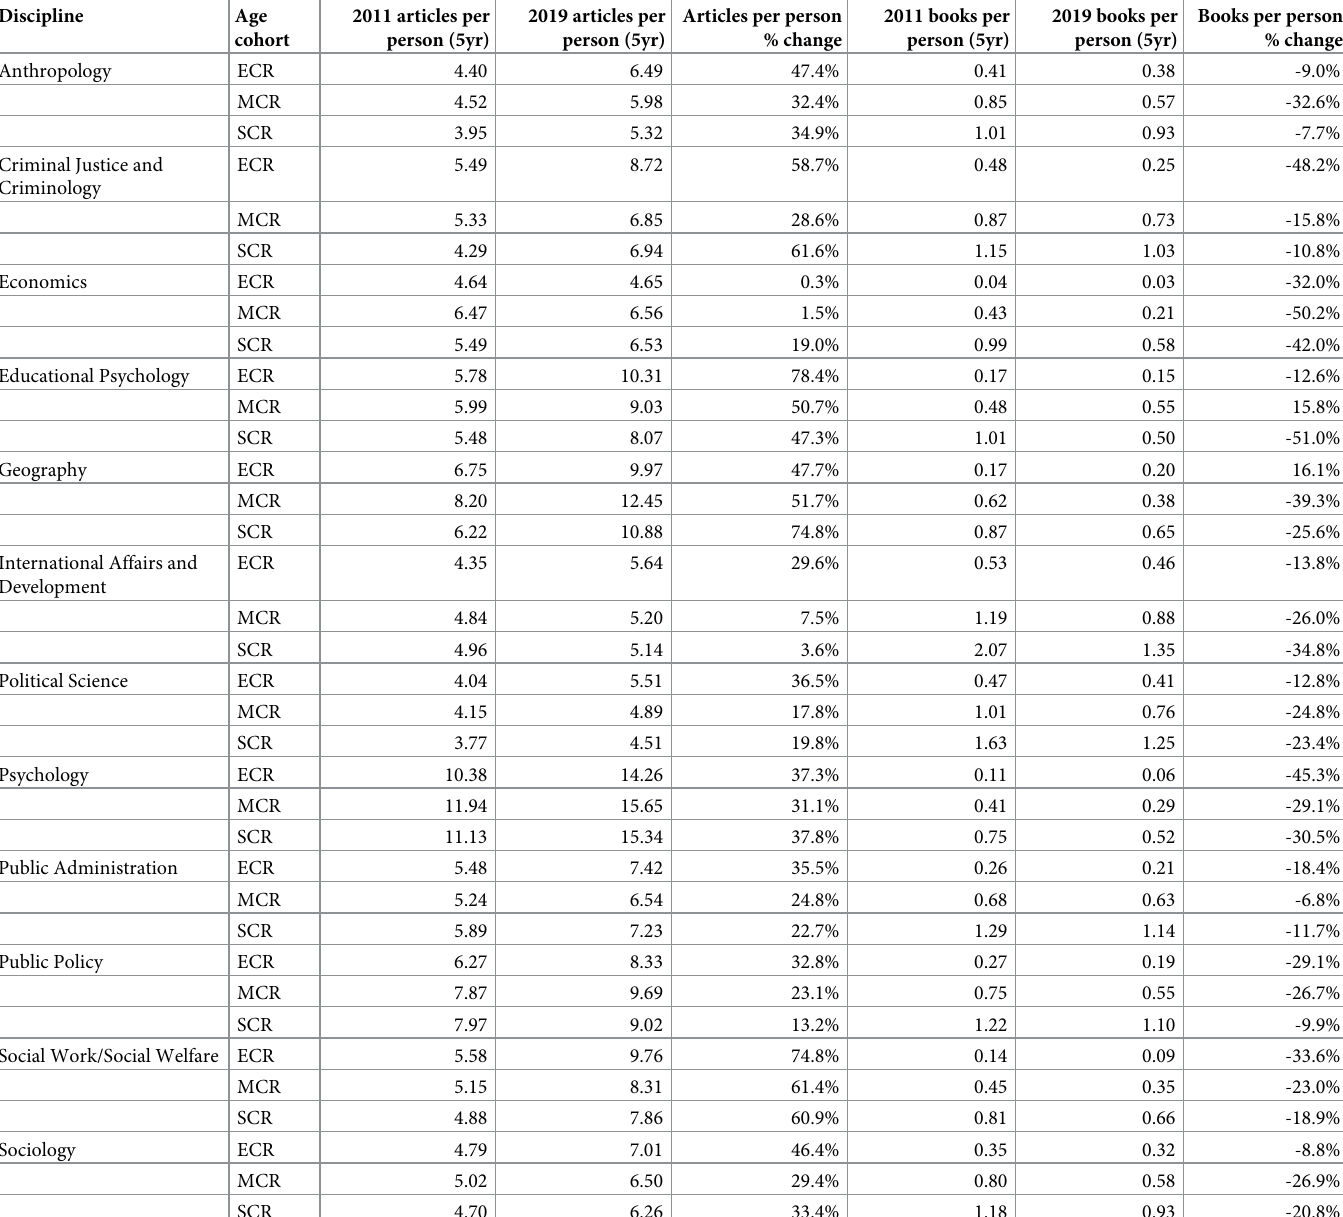
Table 3. Article (5-year count), and book (5-year count) per person ratios in 2011 and 2019 for each age cohort.